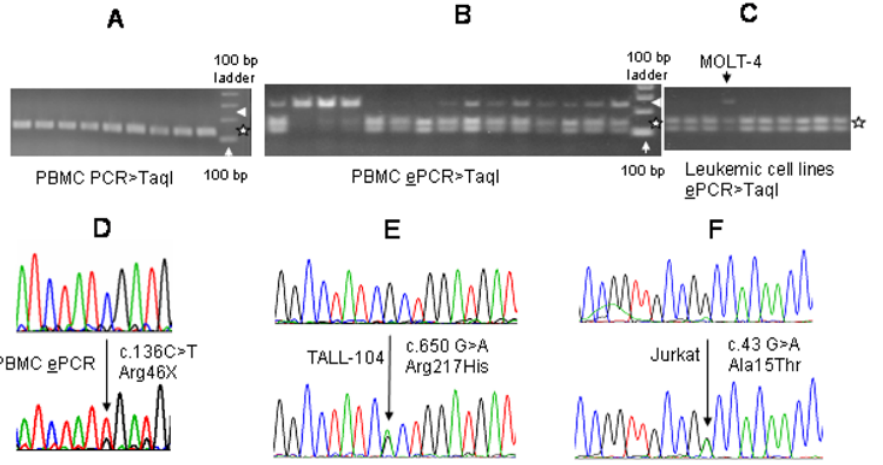
Figure 3. SDHBmutations in genomic DNAs (gDNAs). A . Taq I RE digestion of PCR-amplified exon 2 shows no evidence of undigested mutant DNAs at 260 bp size (pointed by an arrow head). Taq I RE digestion products of the wild-type DNA co-migrate at sizes of 128 and 132 bps (denoted by a star). B. Gel electrophoresis of Taq I RE-digested (mutation) enrichment PCR (ePCR) products shows variable amounts of mutant gDNAs at 233 bp size (pointed by an arrow head), which are confirmed to be primarily composed of c.136C . T by sequencing (Table 1). Taq I digestion of wild-type ePCR products gives two bands at sizes, 101 and 132 bp (shown by a star). C. ePCR analyses of leukemic cell lines demonstrate the presence of mutant gDNA in the MOLT-4 cell line (pointed by an arrow head) but not in other leukemic cell lines in this experiment. D. Direct sequence analysis of a gDNA ePCR product shows selective enrichment of the R46X mutation. E, F. Sequence chromatograms of the heterozygous DNA mutations detected in two T-ALL cell lines are